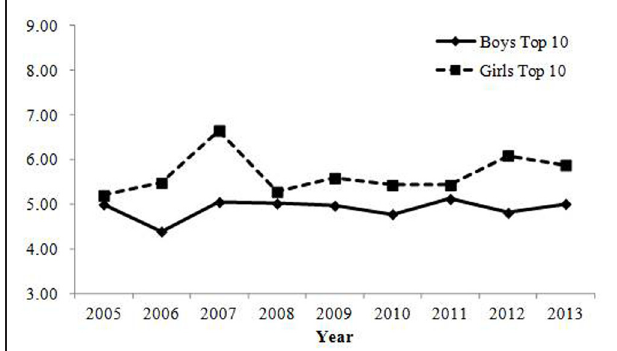
FIGURE 1 | Percentage of babies receiving names with one of the top 10 most common combinations of Chinese characters in Study